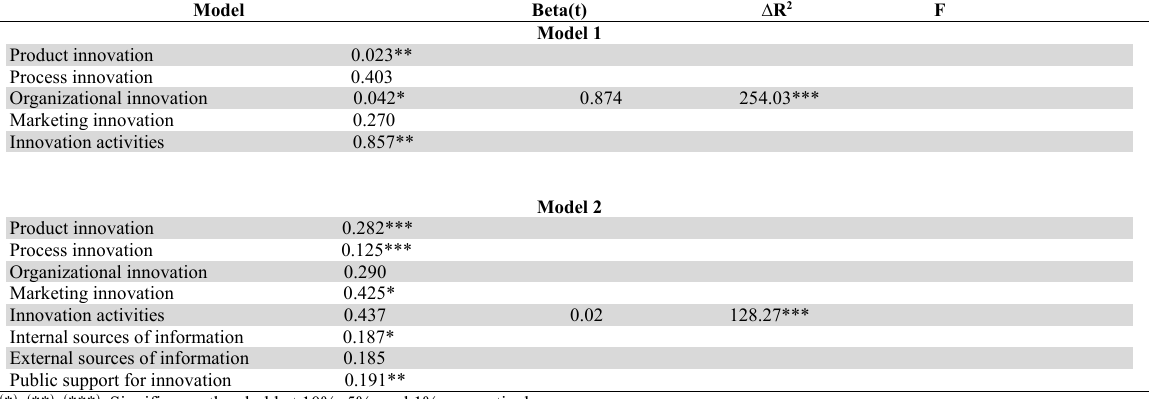
The Marginal contribution to the prediction of the competitive Advantage of